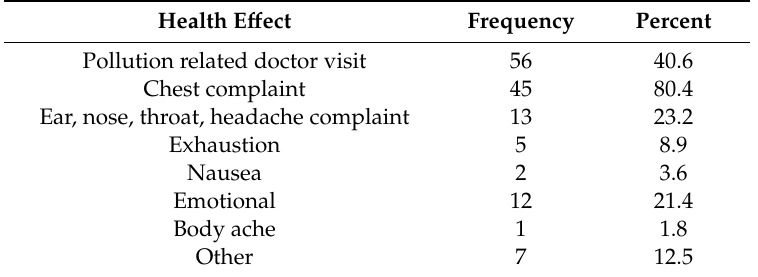
Table 5. Reasons for seeking medical attention for pollution-related health e ff